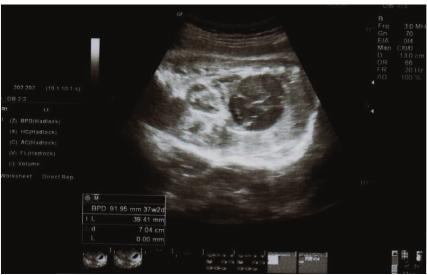
Figure 1: Ultrasonographic appearance of cystic neuroblastoma at 37 weeks of gestation.